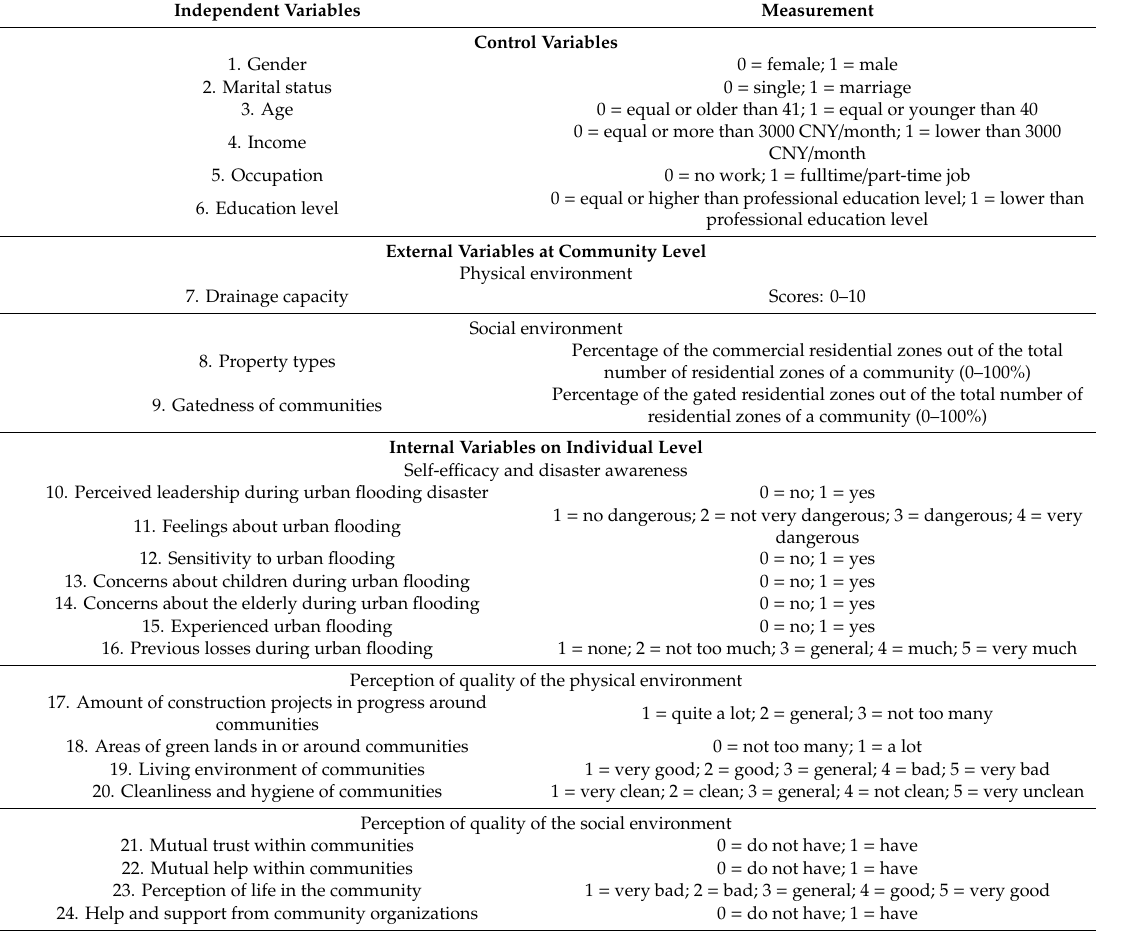
Table 4. Independent variables and their